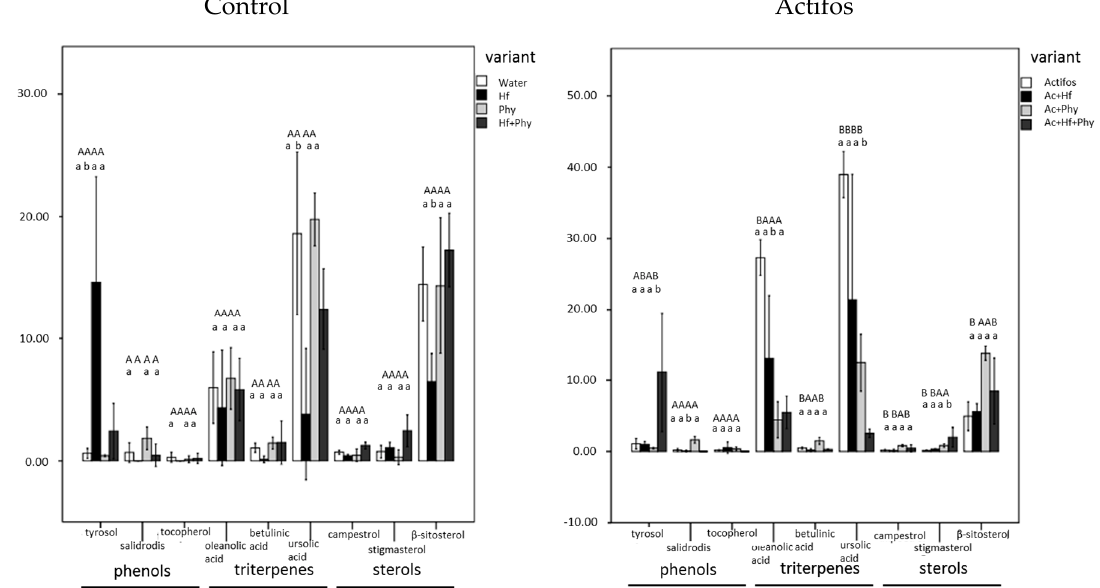
Figure 5. Content (%) of selected compounds in extract from the shoots of F. excelsior subjected to ammonium phosphite treatment (water and Actifos) after control for Hf, Phy, and Hf + Phy infection. Lowercase letters indicate significant differences ( p < 0.05 Kruskal–Wallis and Mann–Whitney U -test) between mock-inoculated and fungal inoculated plants within the same treatment (water and Actifos). Uppercase letters indicate significant differences ( p < 0.05 Mann–Whitney U -test) between plants subjected to different treatments and the same inoculation type.